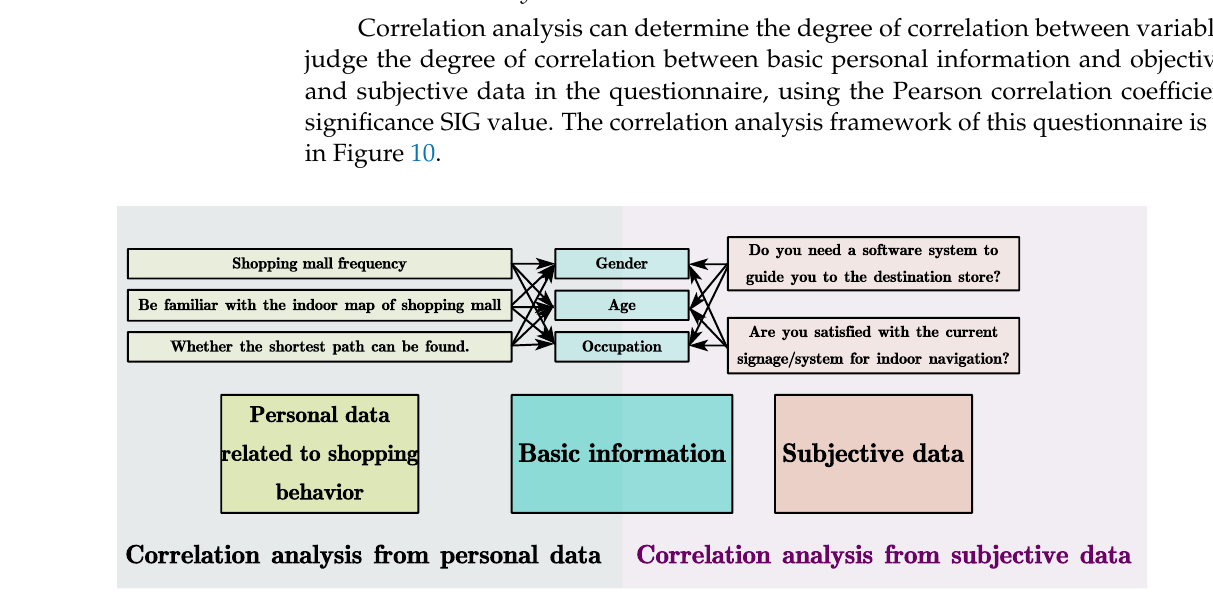
Table 8. Correlation analysis between characteristics (personal basic information) and status varia- bles (objective data) 1 .